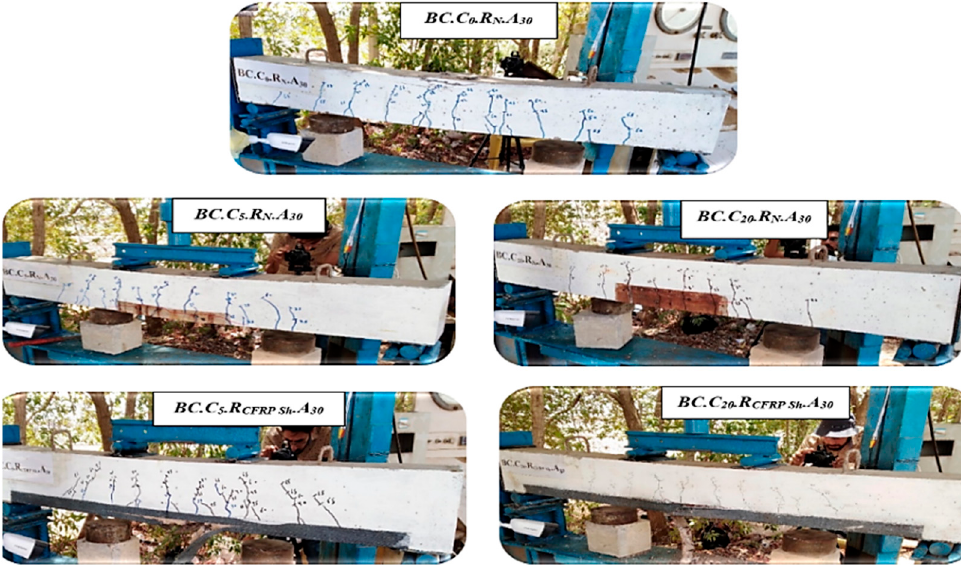
Figure 7. Cracking patterns at failure for specimens in group B.